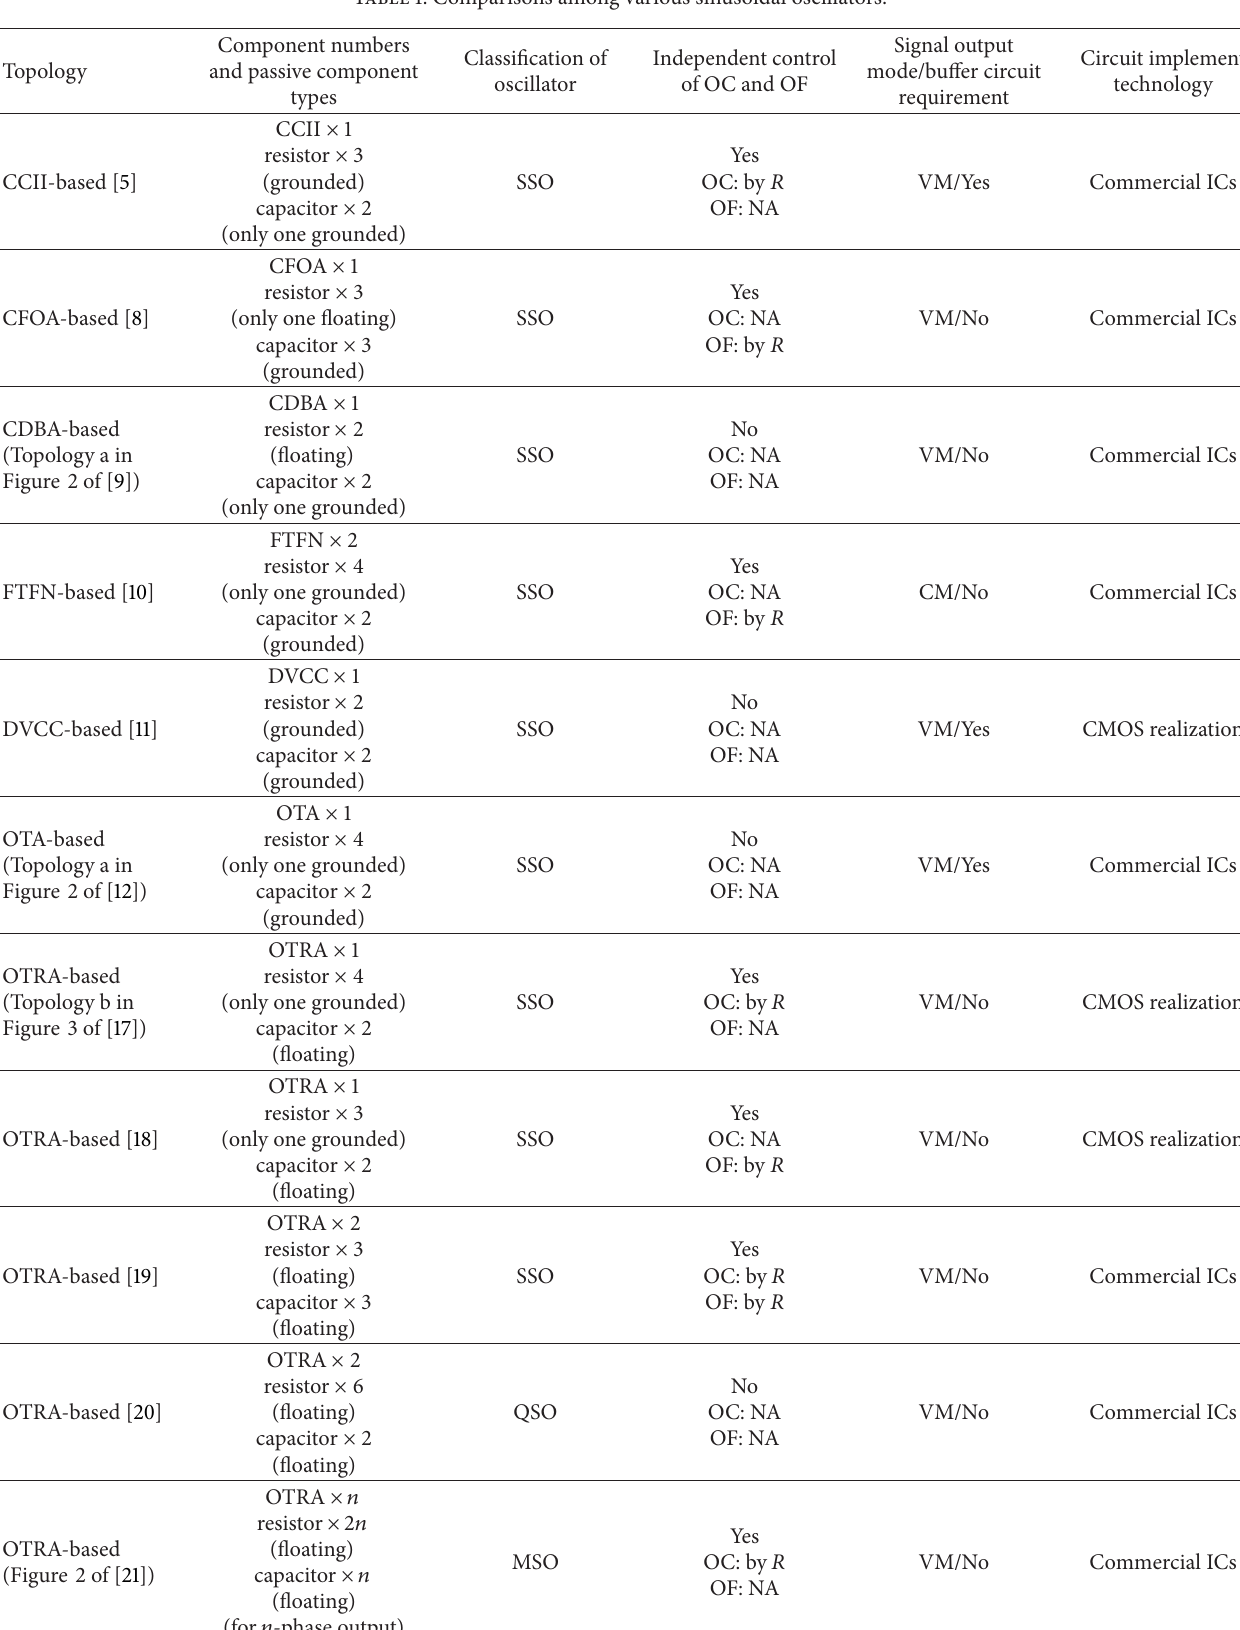
Table 1: Comparisons among various sinusoidal